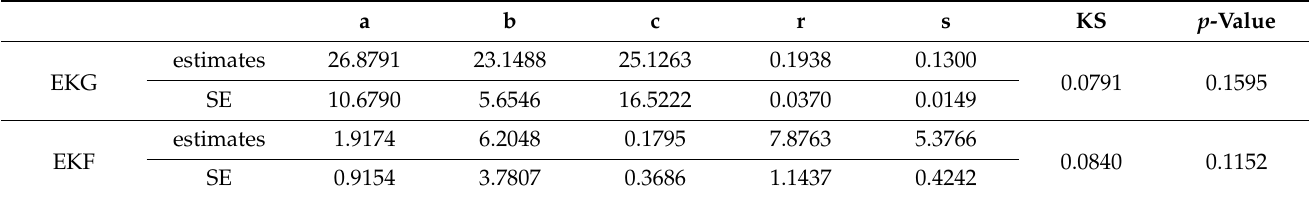
Table 11. MLE with standard error (SE) and KS test for different sets and different model for Australian athletes data set.